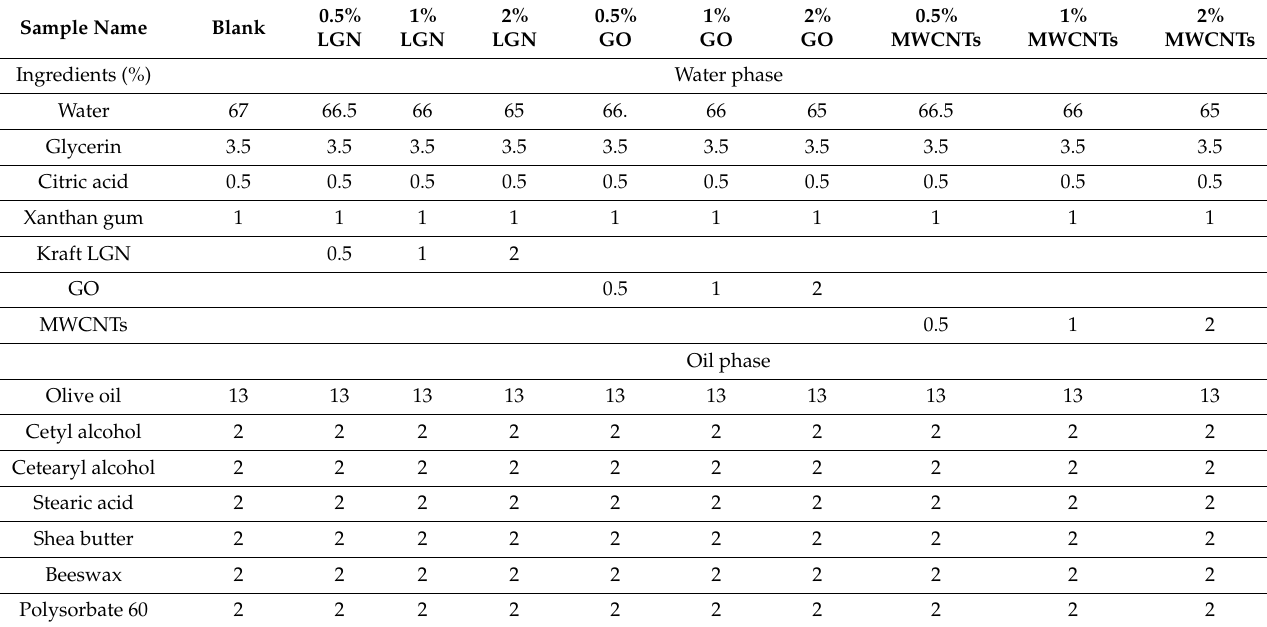
Table 1. Ingredients of the prepared O/W